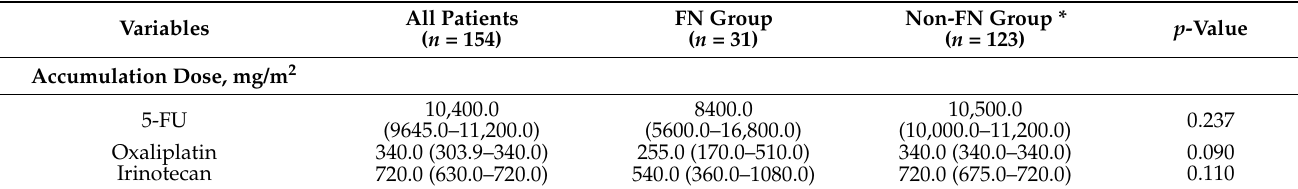
Table 2. Treatment characteristics preceding FN development.